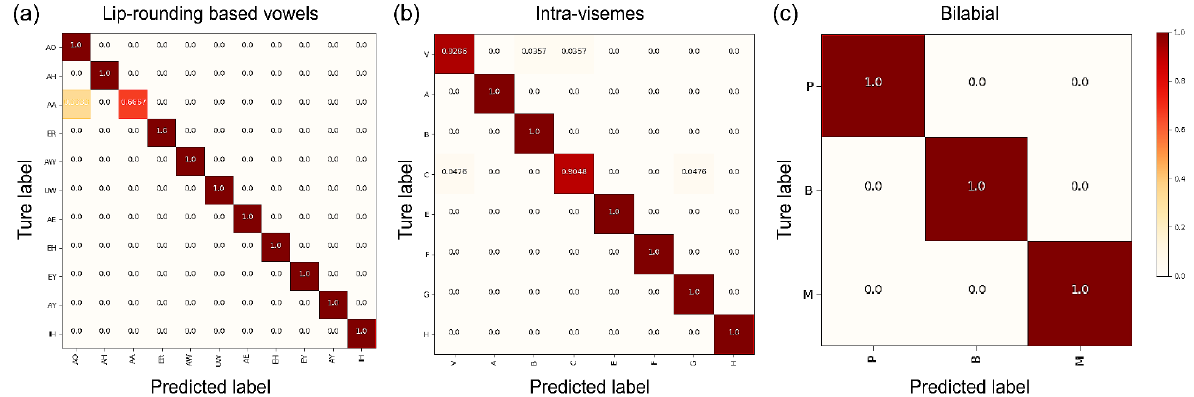
Figure 11. Detailed proposed architecture confusion matrices for the ( a ) lip-rounding based vowels; ( b ) intra-visemes; ( c ) bilabial groups. The three groups with the greatest confusions and confusions inside viseme clusters were selected.